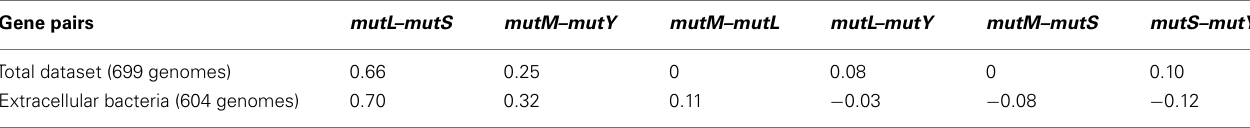
Table 2 | Φ Coefficient for pairwise distributions of DNA repair genes.